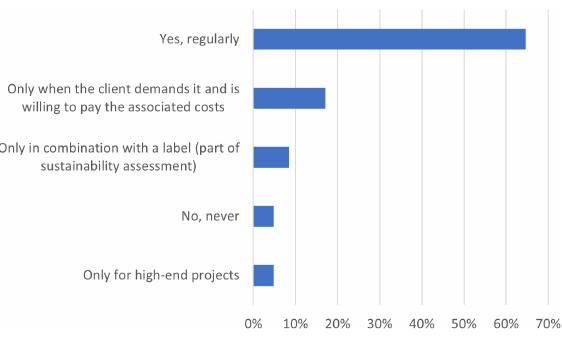
Figure 7. Motivation for considering environmental performance assessment results in the design decisions (based on 74 respondents, more than one answer could be selected).